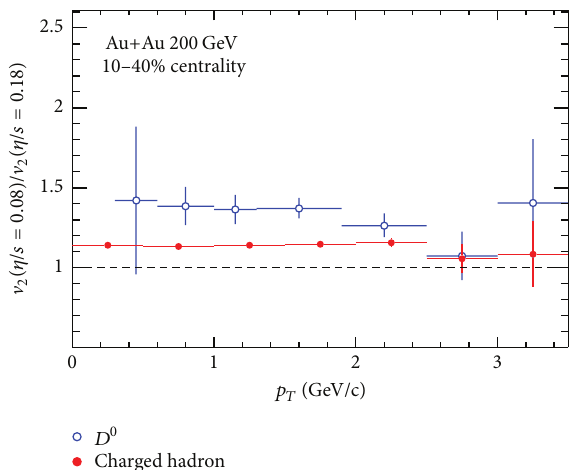
Figure 1: Ratio between V 2 for 𝜂 𝑠 /𝑠 = 0.08 and for 𝜂 𝑠 /𝑠 = 0.18 as a function of 𝑝 𝑇 in Au+Au collisions at √𝑠 NN = 200 GeV for charged hadrons and 𝐷 0 for 10–40% central collisions.